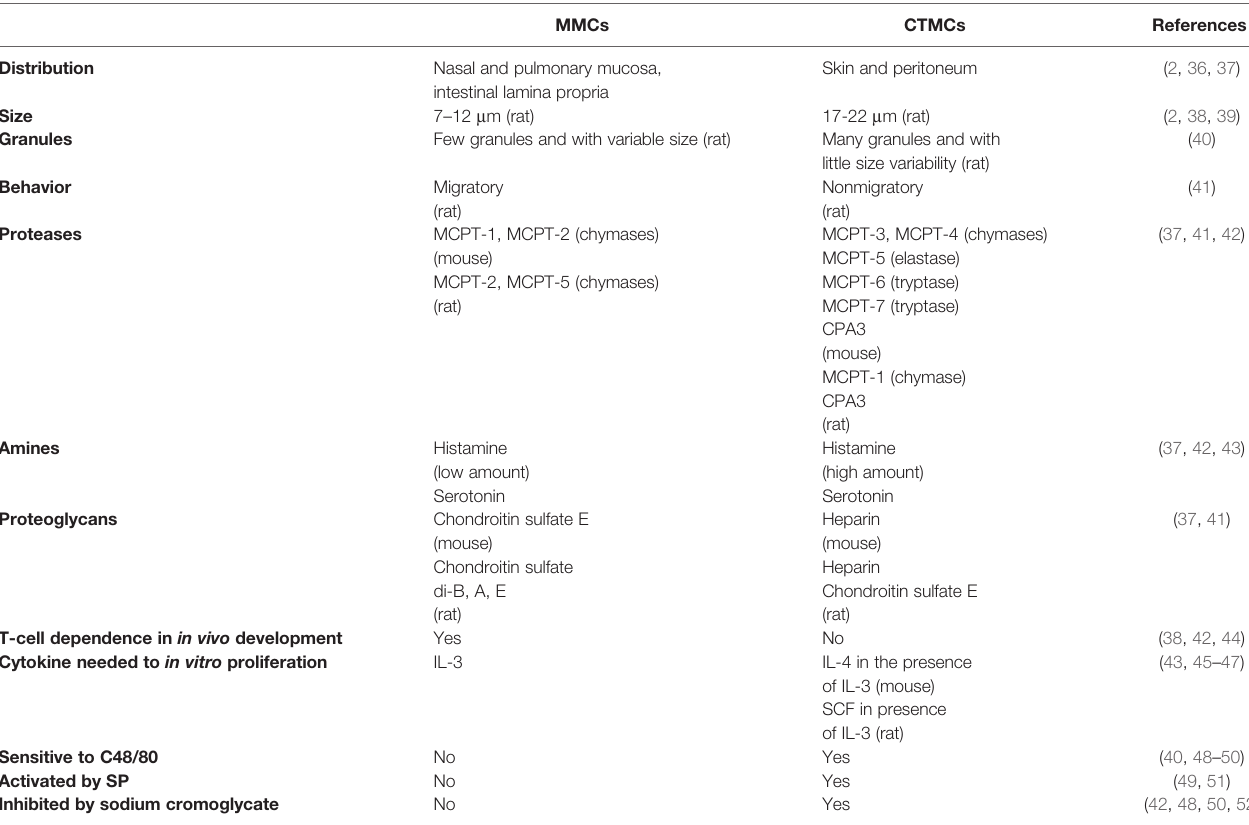
TABLE 1 | Main characteristics of MC types described in